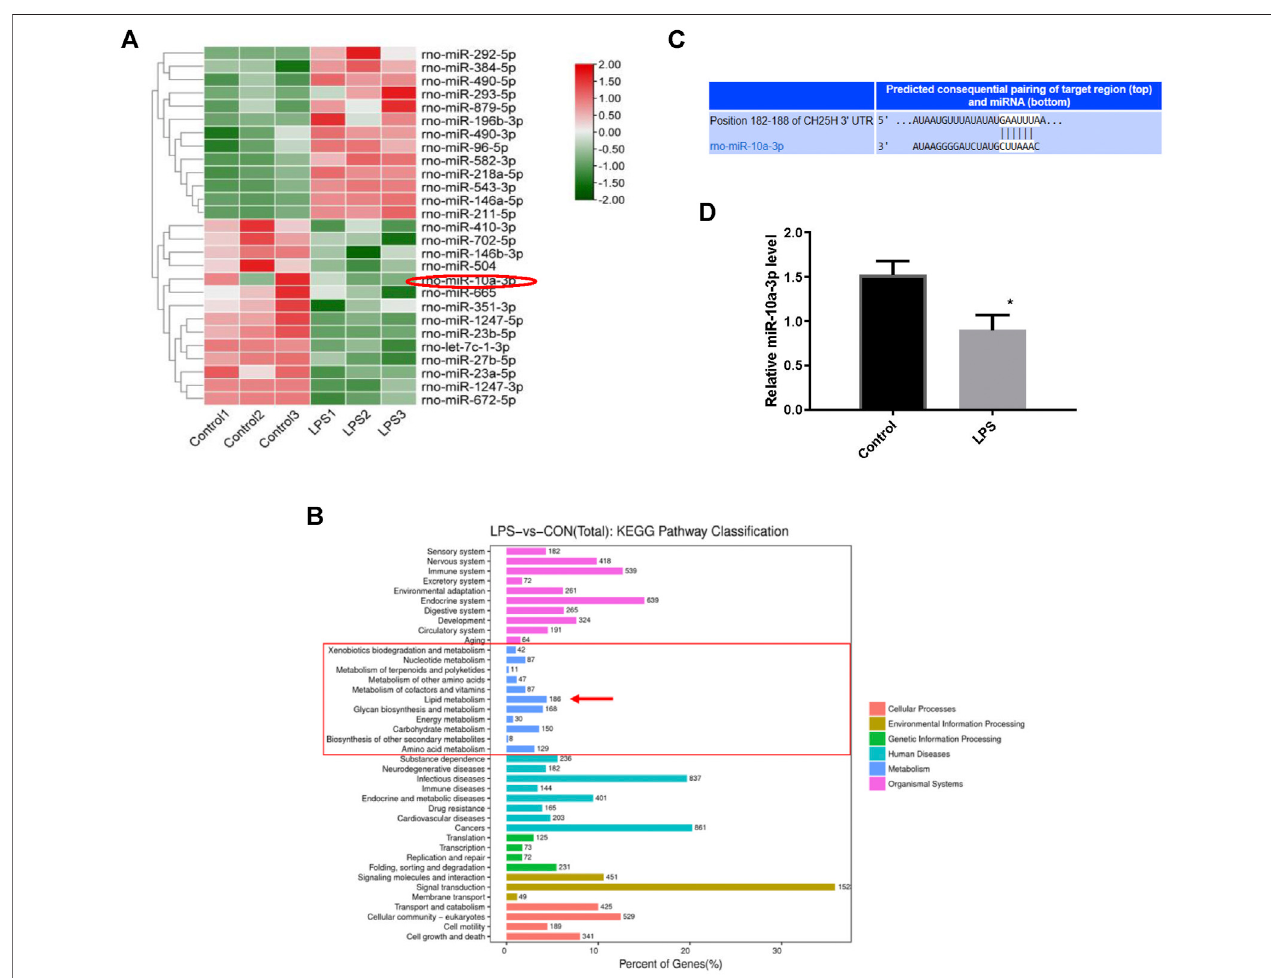
FIGURE 2 | MiRNAs pro fi ling between normal and LPS-stimulated chondrocytes. (A) Differential expression levels of miRNAs between the Control and LPS- stimulatedchondrocytes. (B) TheputativebindingsitebetweenmiR-10a-3p andCH25H mRNAwaspredicted byTargetScan. (C) Differentexpression ofmiRNAtarget geneenrichmentpathwaysfromKEGGanalysis. (D) LevelsofmiR-10a-3pexpressionincontrolandLPS-stimulatedchondrocytes,asdeterminedbyqRT-PCRanalysis ( n (cid:1) 3). The quantitative data are presented as the mean ± SD. * p < 0.05 vs. control.